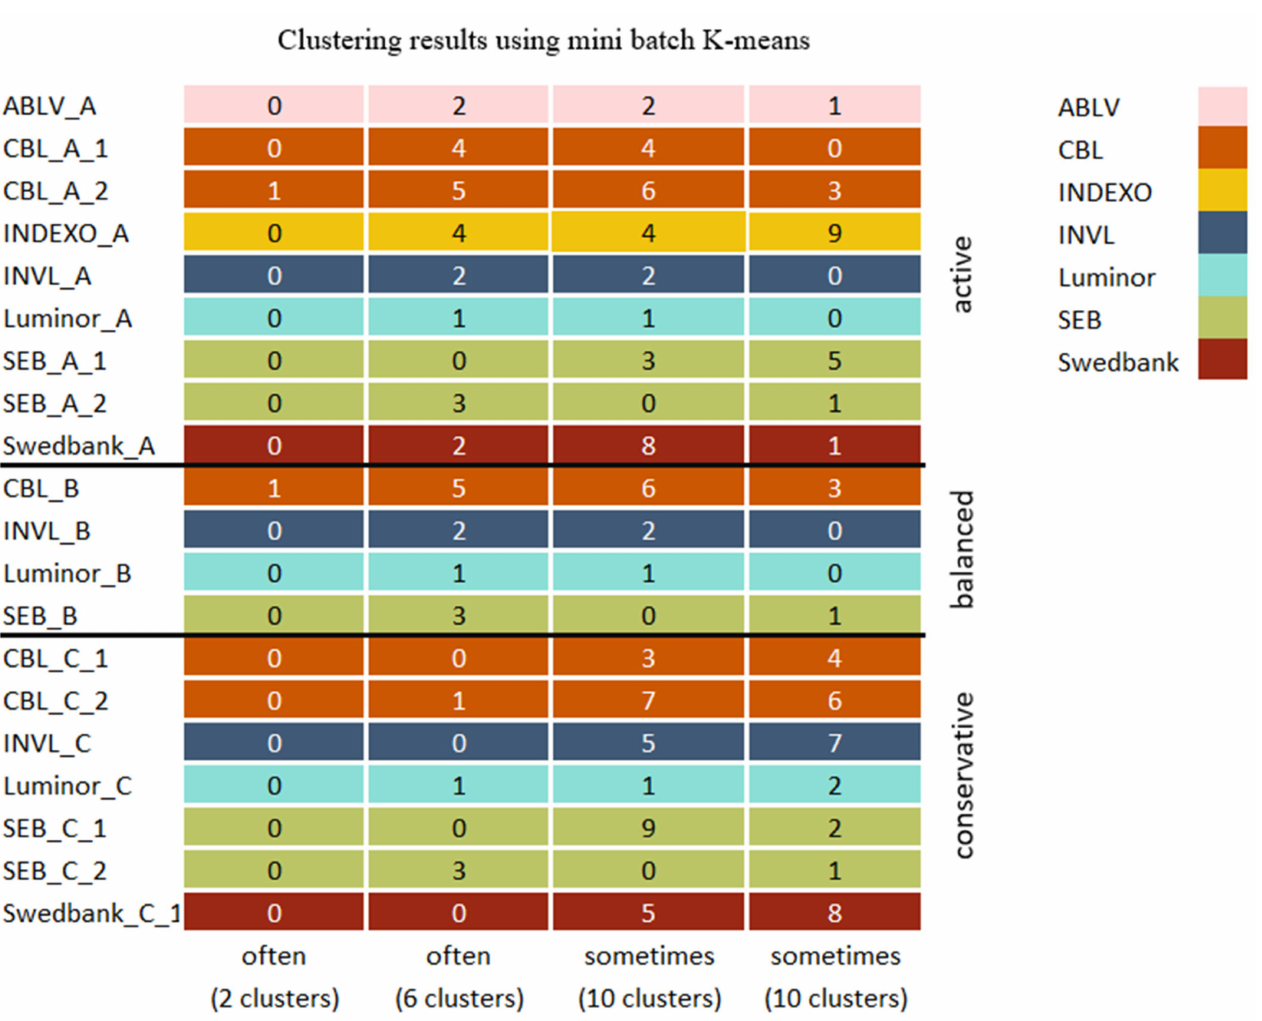
Figure A2. Top 50 best mini batch K-means algorithm results based on silhouette score using different number of clusters. The cluster value is noted in the parentheses, and the most often occurring combinations are